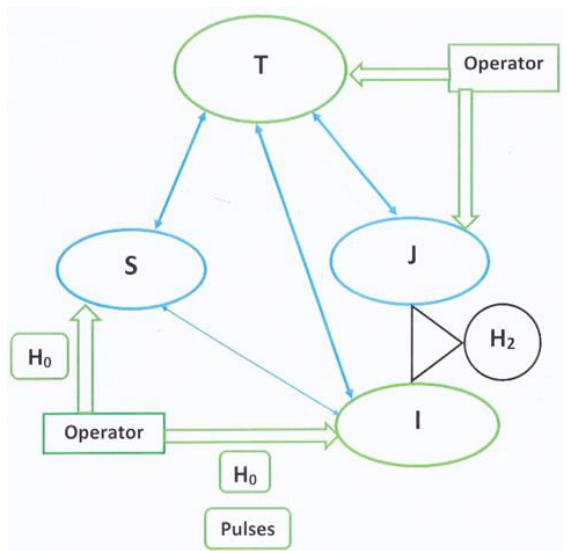
Figure 9. T is the thermal bath of the adsorbed molecules and solid phonons, S represents the orbital and spin electronic angular momenta. J and I are the nuclear rotational and spin hydrogen system. The operator controls the temperature, the conditions of the scatterings and might apply magnetic fields and radiative